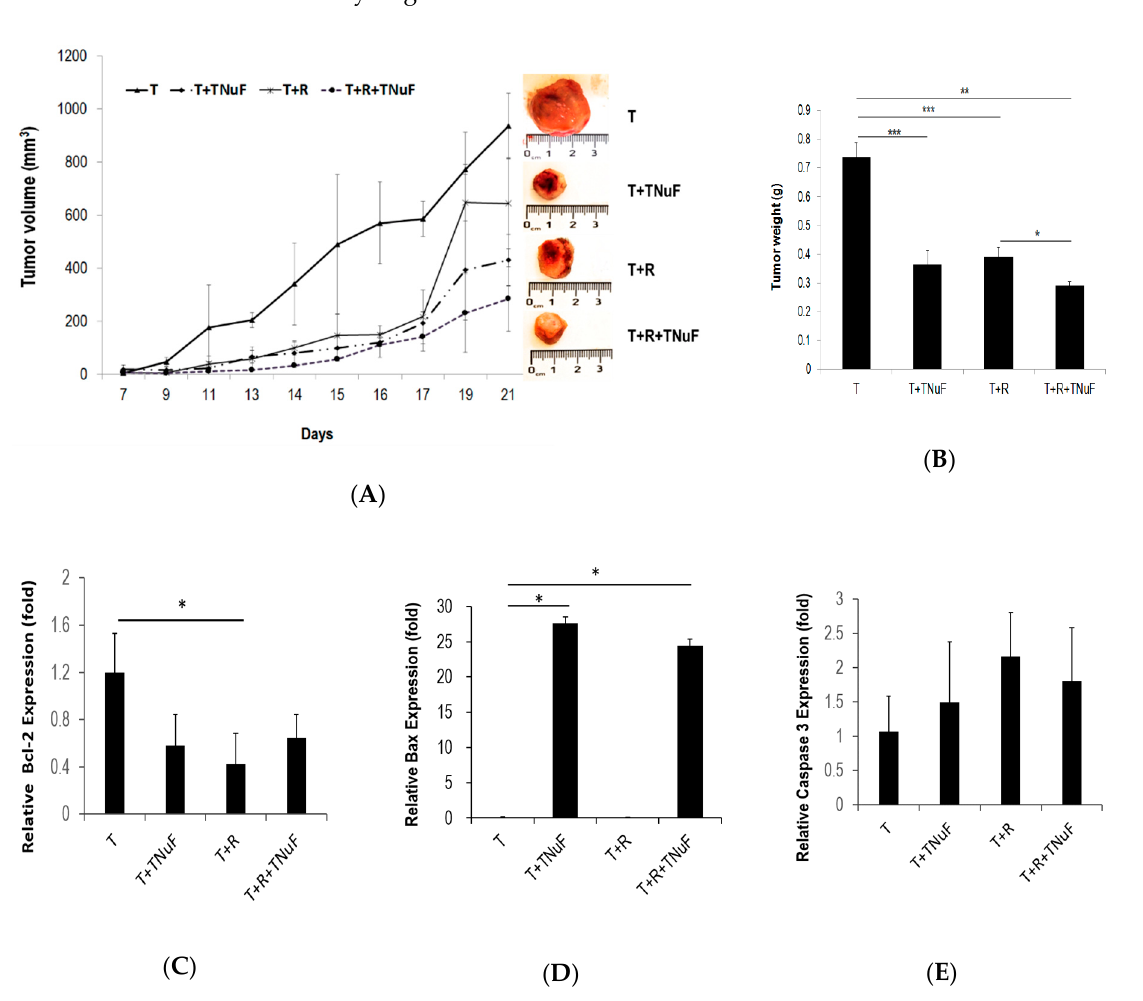
Figure 2. The e ff ects of TNuF and / or irradiation on the growth of xenograft tumor. ( A ) Tumor volume growth curve with various treatments and representative tumors from the mice in due course. ( B ) The tumor weights measured at the end point. mRNA levels of ( C ) Bcl-2, ( D ) Bax and ( E ) caspase 3 in the tumor tissues of mice treated with TNuF, irradiation, and the combination of TNuF and irradiation. Data are expressed as the means ± SD. * p < 0.05, ** p < 0.01, *** p < 0.001 when compared to the indicated group.